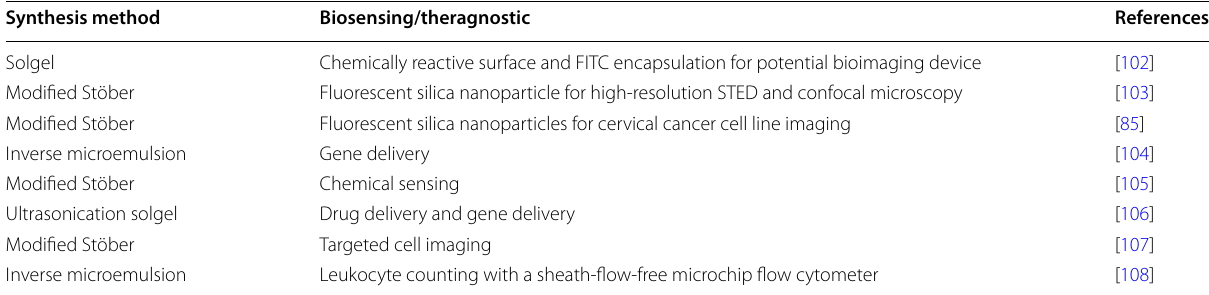
Table 3 Diverse synthesis routes for silica nanoparticles and their applications Synthesis